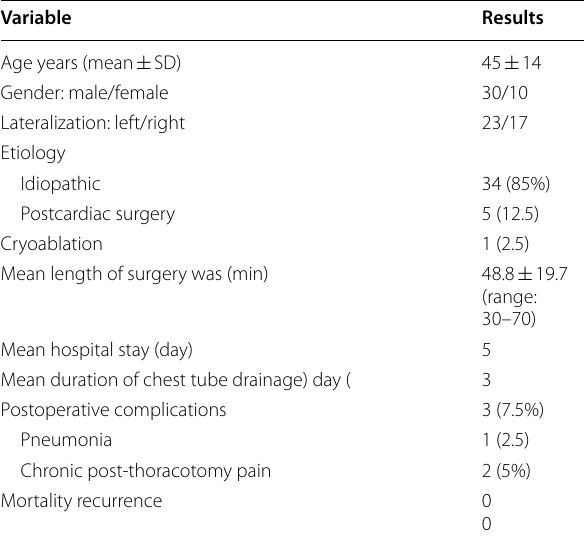
Table 1 Preoperative, operative, and postoperative data of the